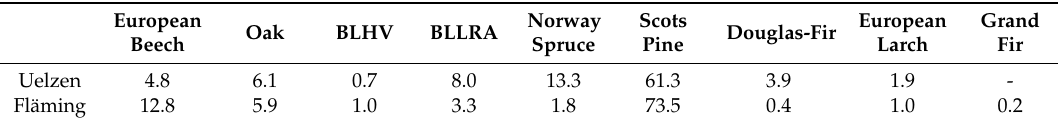
Table 1. Proportions of species area [%] in Uelzen and Fläming in 2011 according to available inventory data (BLHV = broadleaves of high value; BLLRA = broadleaves of low rotation age).